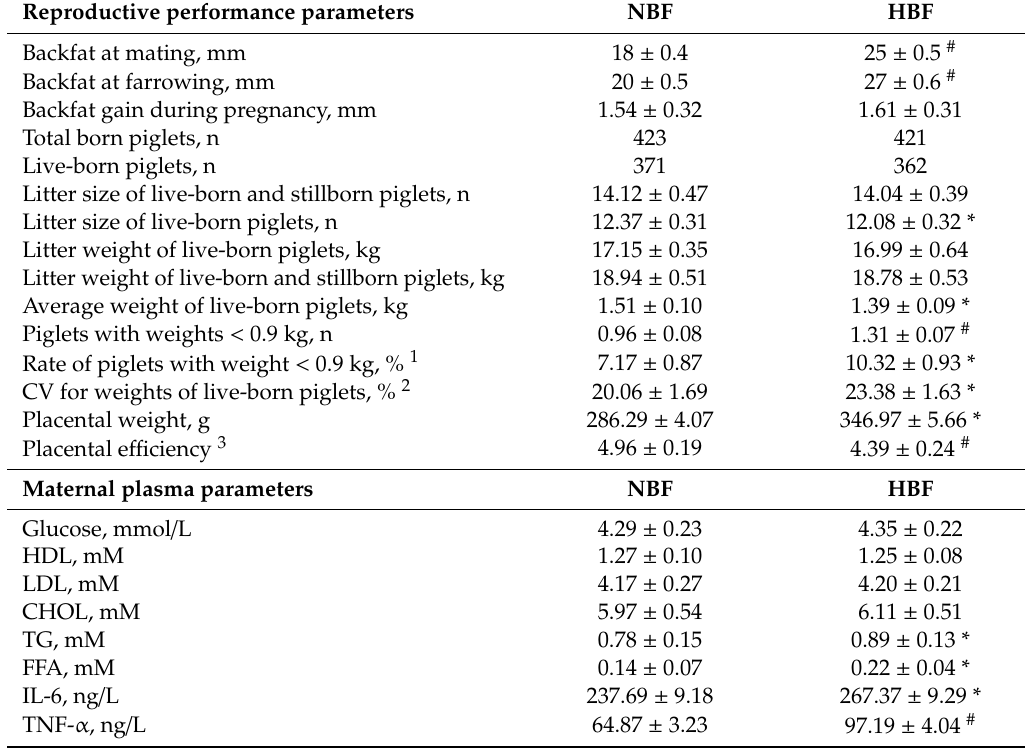
Table 1. Characteristics of the studied